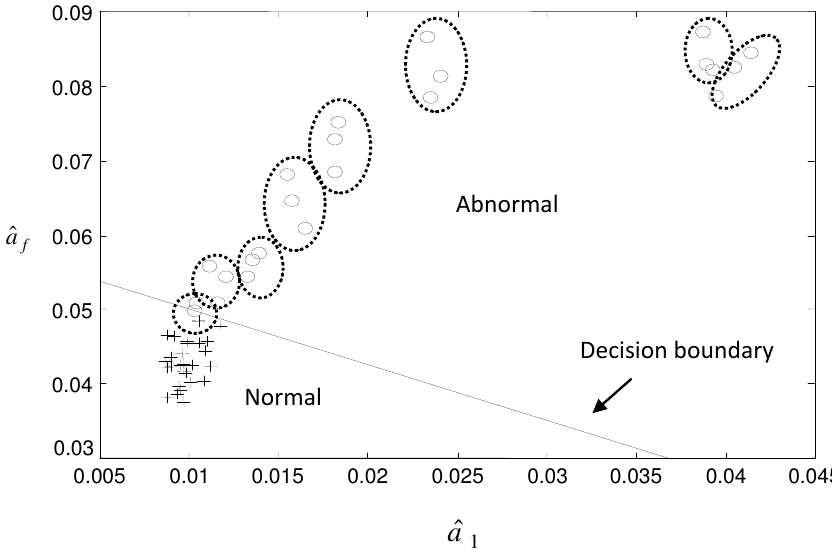
Figure 7. The decision boundary that partitions the input space ( â corresponding to normal and abnormal components. The dashed circles that encircle the data points belong to the same solenoid. The solenoids classified as normal are marked with “+”, while the abnormal solenoids are